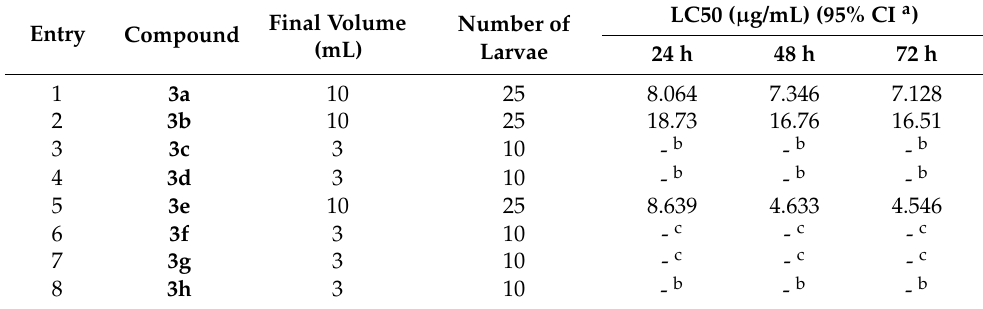
Table 4. LC 50 ( µ g/mL) data for compounds 3a – g .